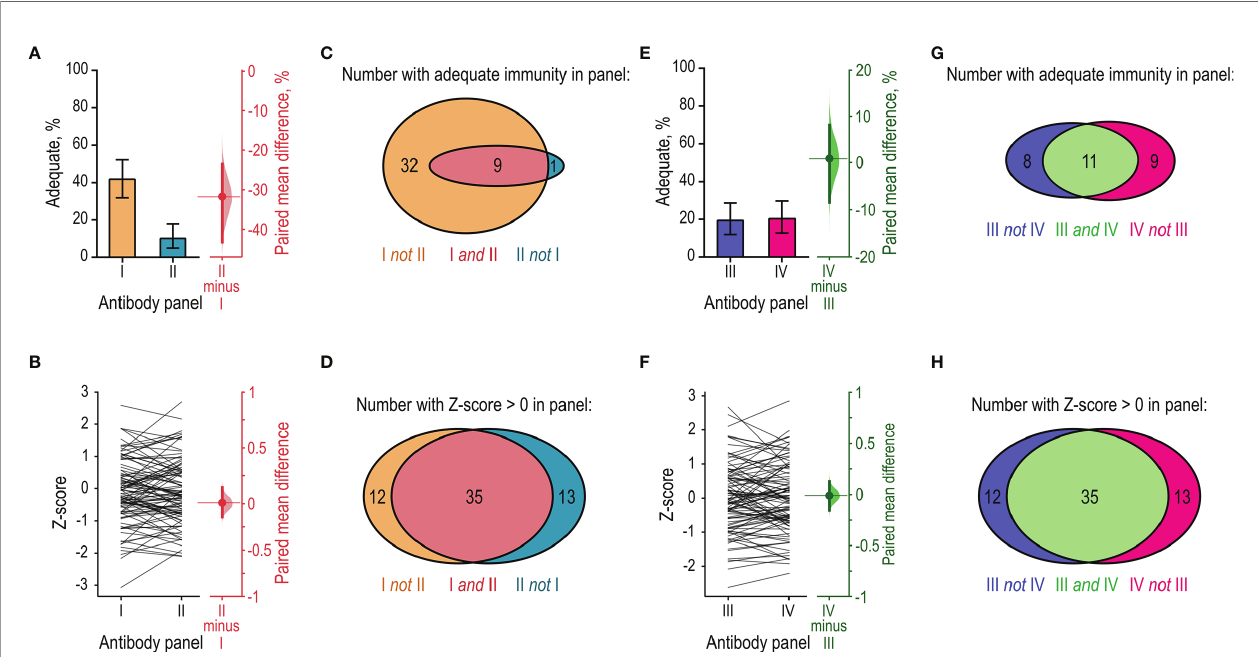
FIGURE 5 | Sensitivity-analysis of interpretation using the AAAAI guidelines and Z-scores. The same cohort of patients ( n = 98) were assessed for adequate immunity after PPV vaccination using different panels of serotype-speci fi c antibodies for the interpretation. Each panel contained six out of the 12 quanti fi ed serotype- speci fi c antibodies. (A) Left: The proportions of patients considered to have achieved ‘ adequate immunity ’ in each of two antibody panels (I and II) according to the AAAAI guidelines. Right: The paired mean difference in proportions (dot) with 95% con fi dence interval (vertical error lines) and bootstrap sampling distribution (normalized histogram). Panel I contained the six serotype-speci fi c antibodies that most frequently had levels of 1.3 mg/L or higher in the patients. Panel II contained the six serotype-speci fi c antibodies that least frequently had levels of 1.3 mg/L or higher in the patients. (B) Left: Paired Z-scores for the individual patients calculated using data from panel I and panel II. Right: The paired mean difference in Z-score from the two panels. (C) Venn-diagram showing the number of patients with adequate immunity in panels I and II under AAAAI guidelines. Panels I and II identi fi ed an unequal numbers of the patients, and the results showed little overlap. (D) As in (C) , but for Z-scores. Panels I and II now identi fi ed comparable numbers of the patients, and the results largely overlapped. (E) As in (A) , but for two other panels (III and IV). These panels were composed to provide an equal proportion of patients with ‘ adequate immunity ’ under AAAAI guidelines. (F) Comparison of the Z-scores calculated for the patients using the data from panels III and IV. (G) Venn-diagram showing the number of patients with adequate immunity in panels III and IV according to the AAAAI guidelines. Panels III and IV identi fi ed comparable numbers of the patients, but the results showed little overlap. (H) As in (G) , but for Z- scores. Panels III and IV identi fi ed comparable numbers of the patients, and the results largely